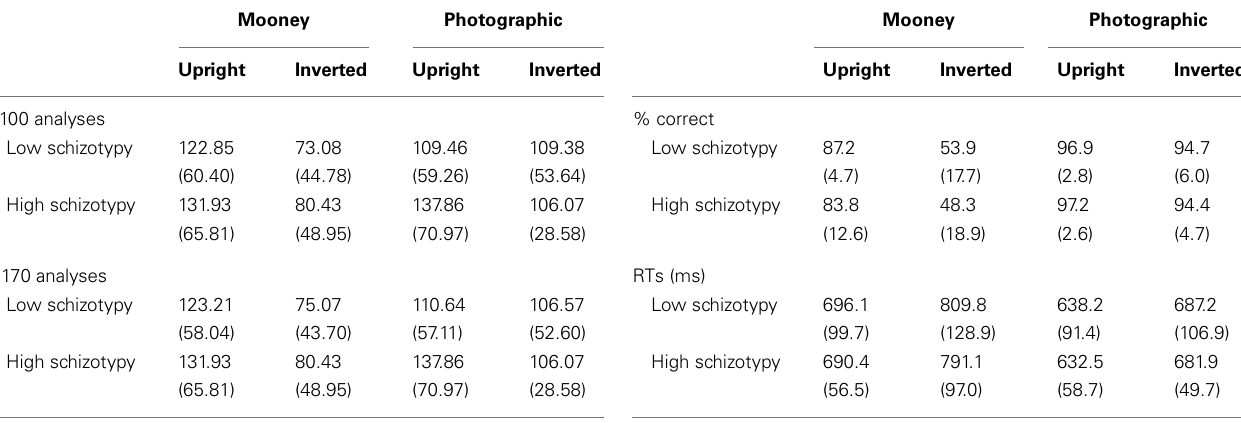
Table 2 | Mean (SD) accepted trials per condition . Table 3 | Mean (SD) accuracy and reaction times per condition